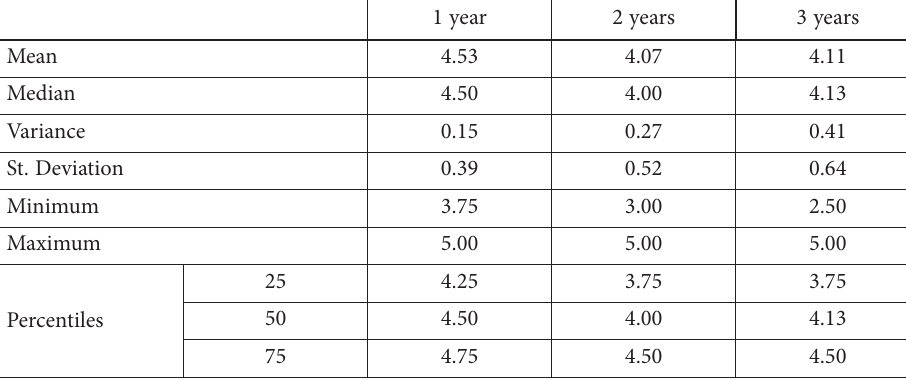
Table 6. Results of Kralicek Quick Test (source: authors based on financial statements)